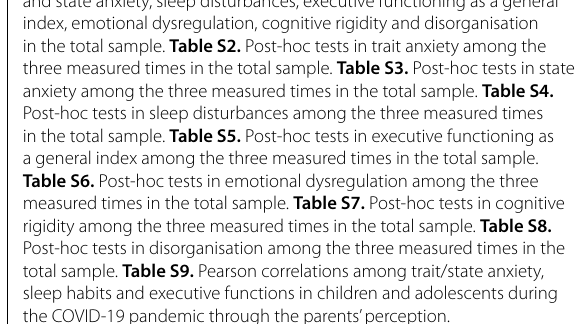
Table S6. Post‑hoc tests in emotional dysregulation among the three measured times in the total sample. Table S7. Post‑hoc tests in cognitive